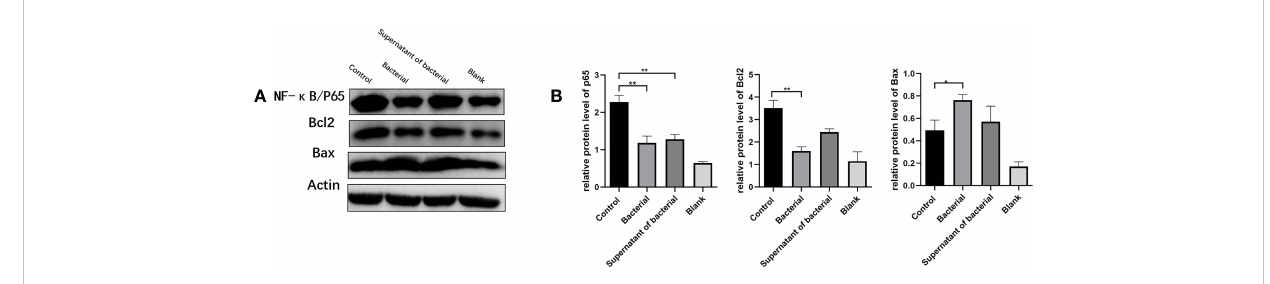
FIGURE 6 CB culture and supernatant inhibited the activation of the NF- k B pathway. (A) Representative Western blot results of NF- k B/P65, Bcl-2, and Bax. (B) Comparison of the expressions of NF- k B/P65, Bcl-2, and Bax proteins. The data are represented by mean ± SEM and compared using one-way ANOVA. *P<0.05,